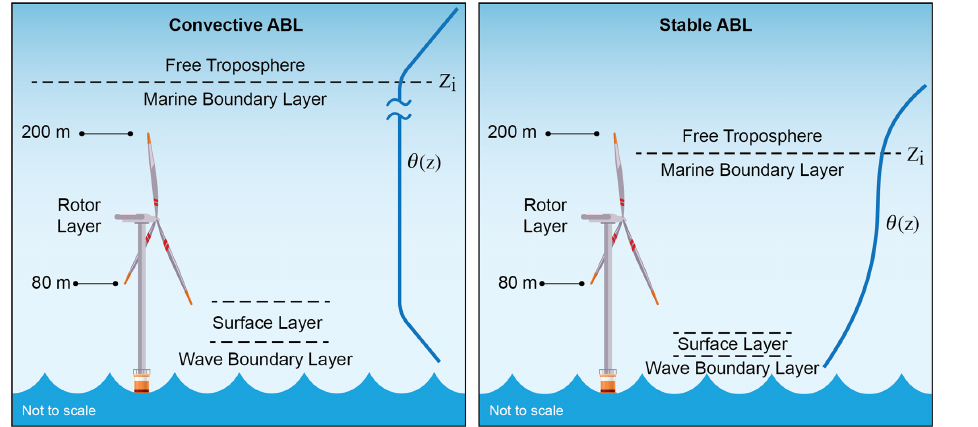
Figure 2. Depiction of the different components of the marine ABL and how those components and overall structure vary with changes of atmospheric stability. θ in the figure is potential temperature and z i is the inversion at the top of the boundary layer. The break in the θ profile indicates that the depth of the convective boundary layer can be much greater than the height of the surface layer. The figure is exaggerated in the vertical for